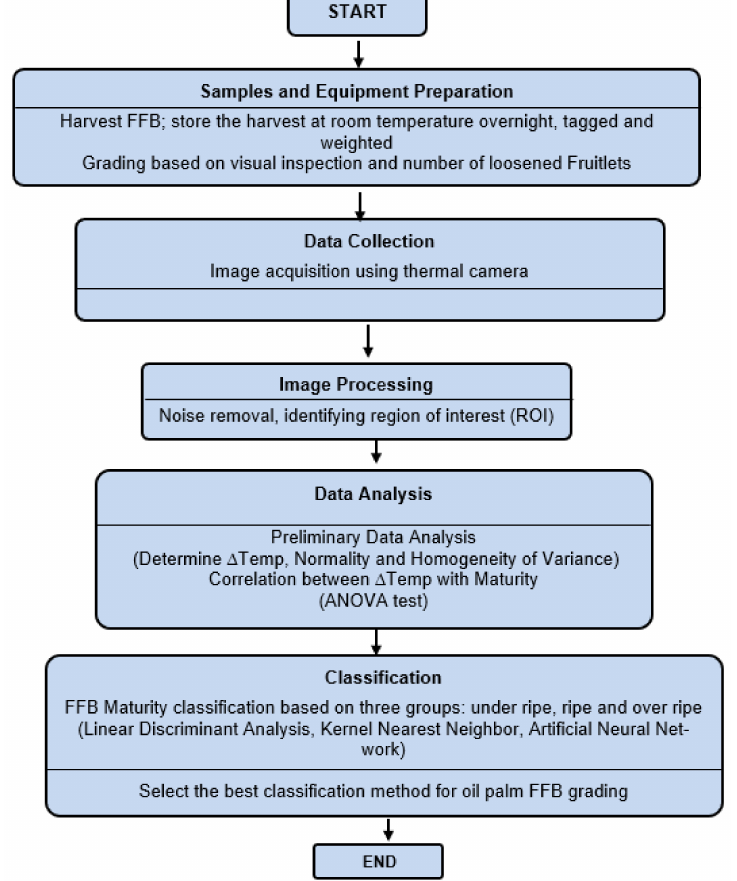
Figure 2. Workflow of research